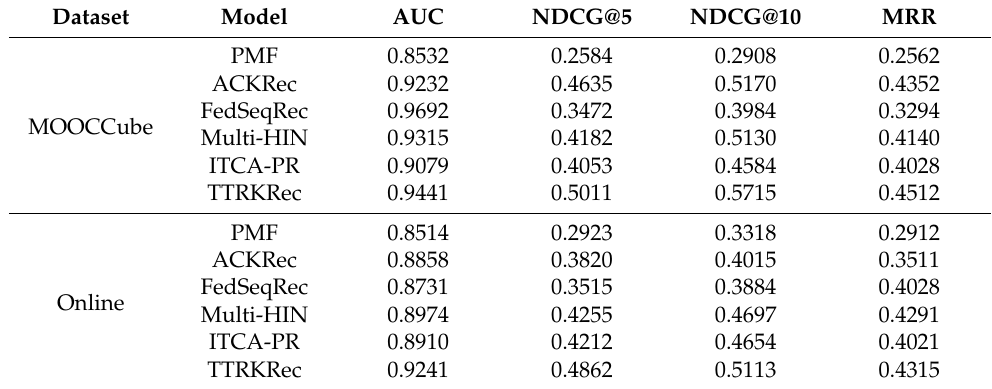
Table 4. Recommendation performance of all methods on the MOOCCube and Online